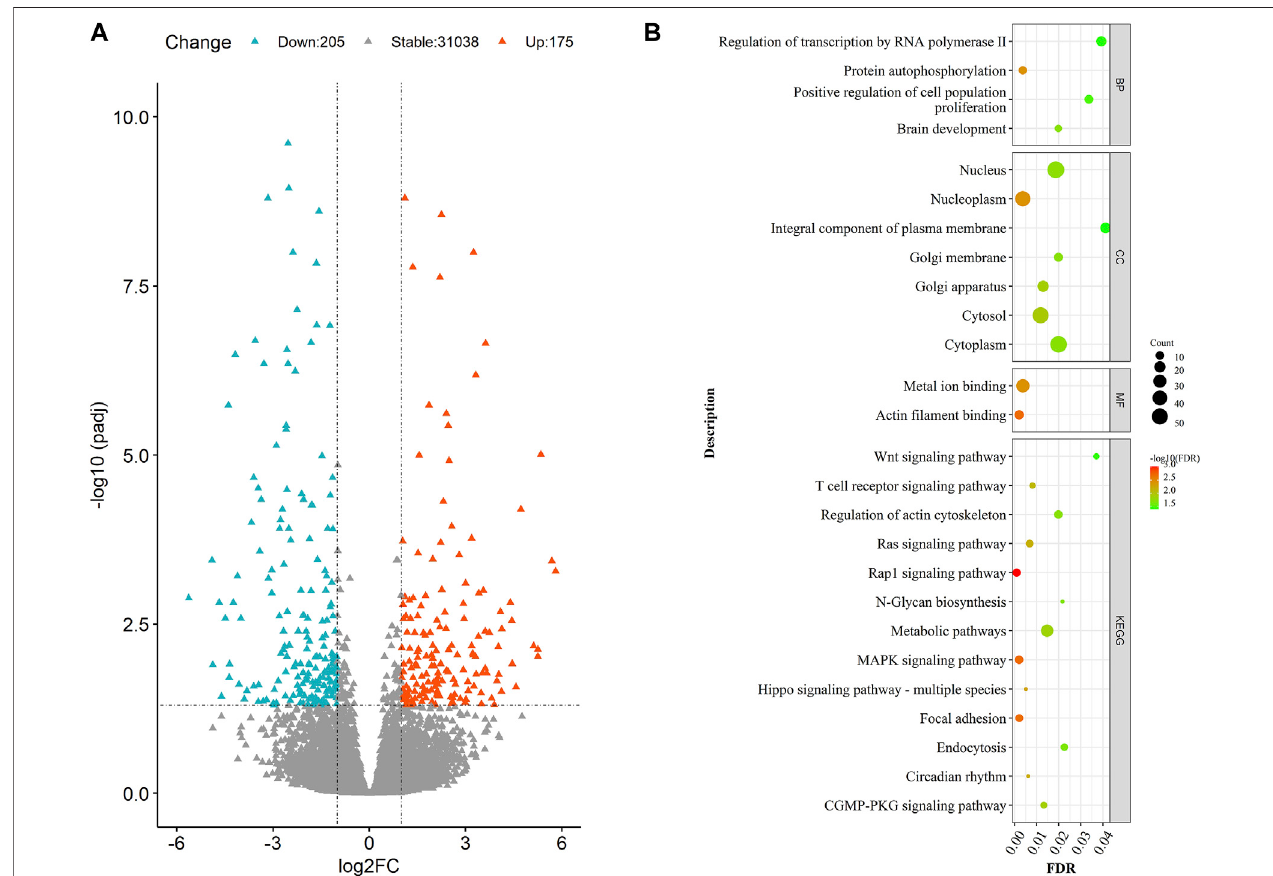
FIGURE 1 | (A) Volcano diagram of DEGs. The volcano diagram exempli fi es the size and signi fi cance of the genes expressed differentially between the HRFI and LRFIgroups.The “ Molokaiblue ” and “ LuminousOrange ” dotsrepresentthedown-regulated andup-regulatedgenesintheLRFIgroup,respectively. (B) GOandKEGG analysis of DEGs. The size and color of the dot represent the number of enriched genes and the magnitude of signi fi cance in (B) .